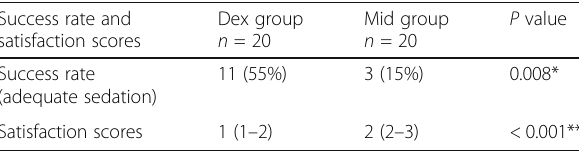
Table 3 Comparison of success rate and satisfaction scores between the study groups Success rate and satisfaction scores